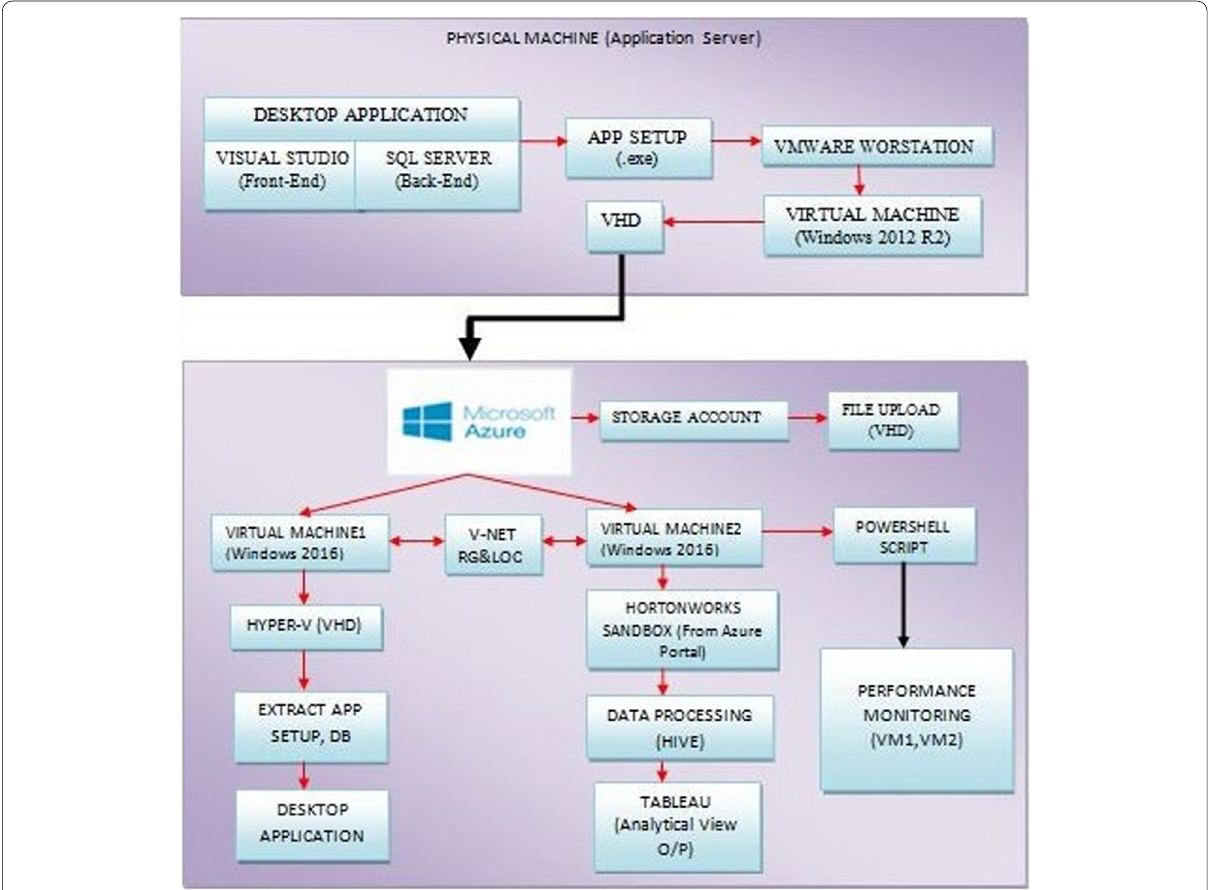
Fig. 1 Physical to virtual to the cloud architecture